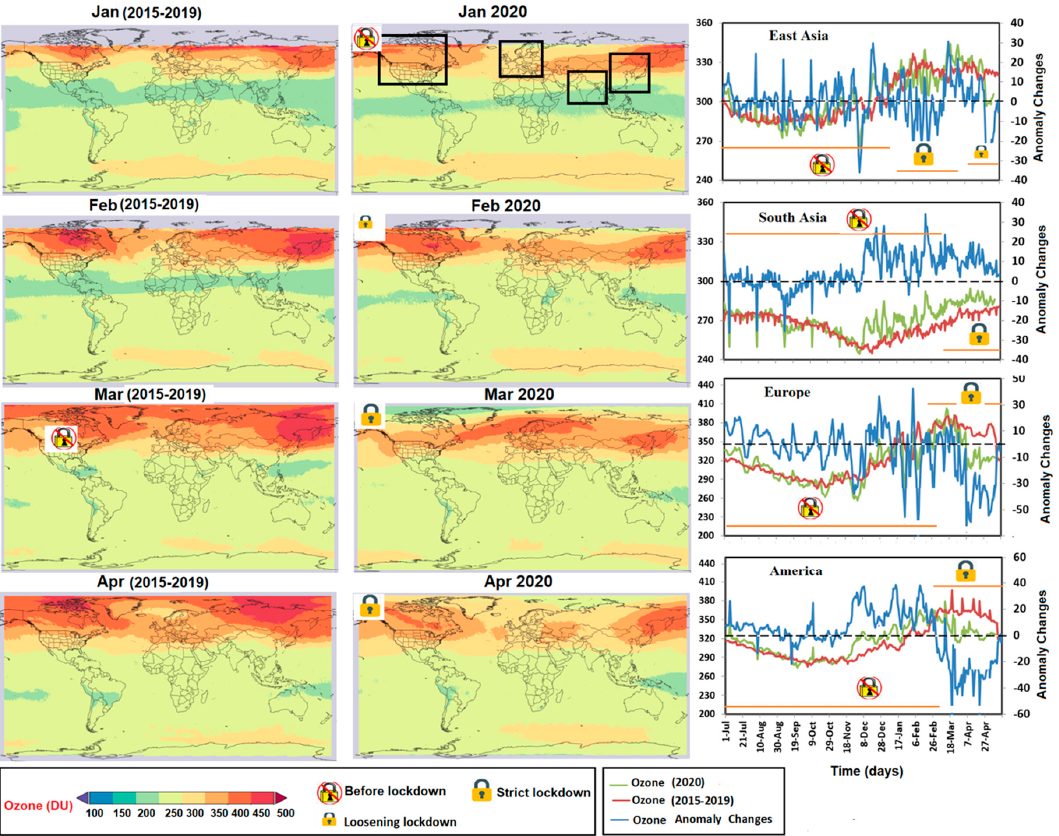
Figure 5. Spatial and temporal variations of the total ozone column compared with the baseline level before and after the lockdown being put into effect in 2020. Gray dotted line in the time series graphs indicates the zero line for anomaly time series.